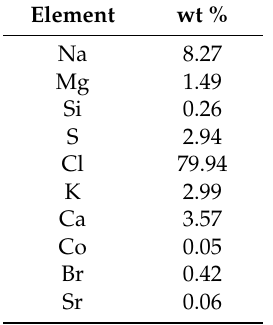
Table A1. Elemental composition of sea water by ED-XRF [13,14].